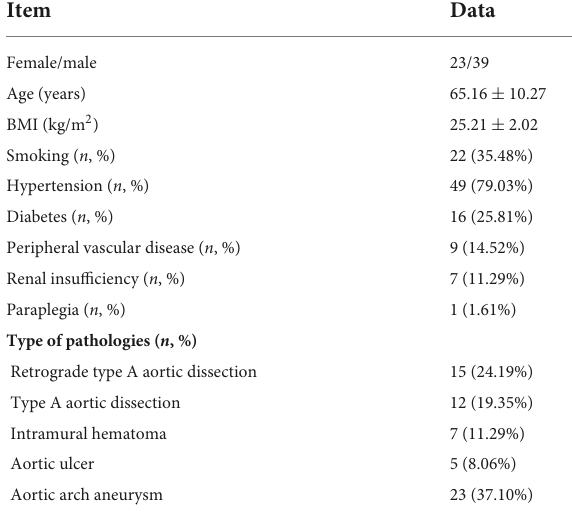
TABLE 1 Demographic